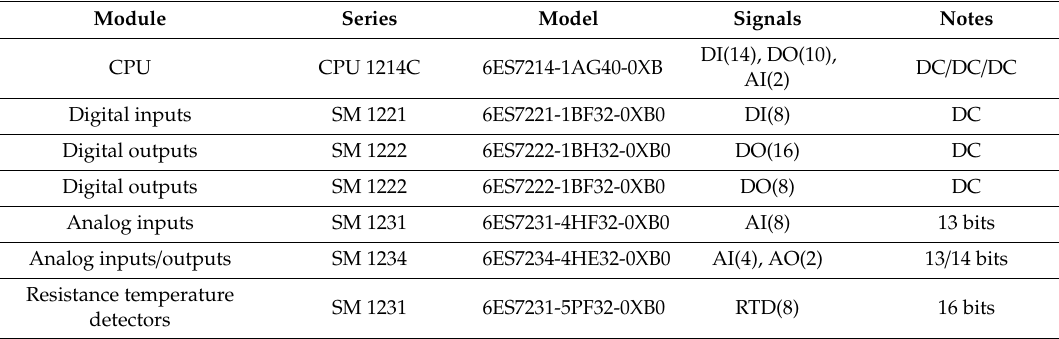
Table 5. Controller technical characteristics. Siemens ® S7-1200